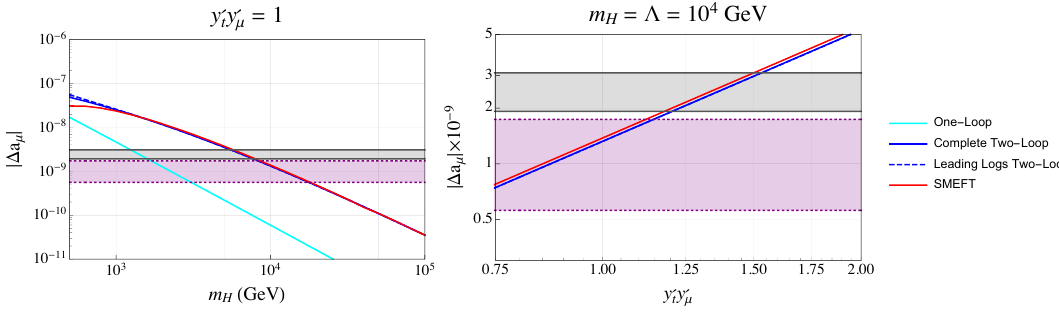
Figure 8 . Left : total contribution to ∆ a µ for different values of m H , with fixed couplings to top and muon, compared to the preferred region by the muon anomalous magnetic moment, represented by the gray and purple bands (see section 4.2 for details). The cyan line shows the correction at one-loop order, while the blue full one includes the two-loop Barr-Zee diagrams. The blue dashed line is obtained by using only leading logarithm terms, see appendix C. The red line instead shows the SMEFT running and matching with eq. (5.10) as the initial condition and Λ = m H . Right : total contribution for different values of the product y 0 y 0 , at fixed m H = Λ = 10 t µ